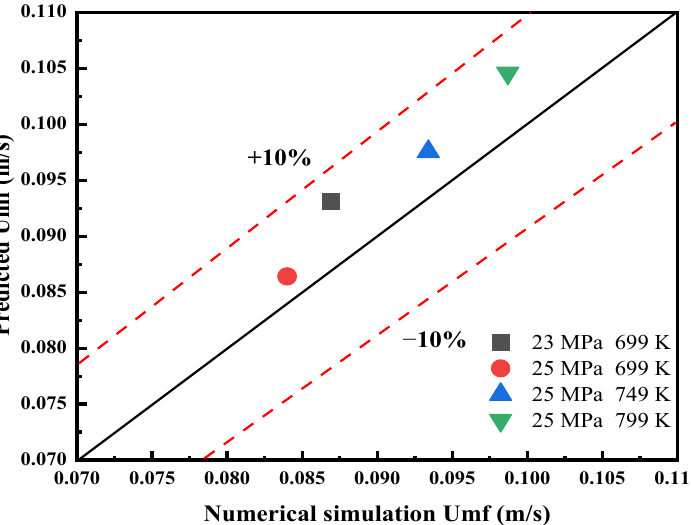
Figure 3. Comparison between numerical simulation and prediction of minimum fluidization ve- locity under different temperature and pressure conditions. under different temperature and pressure